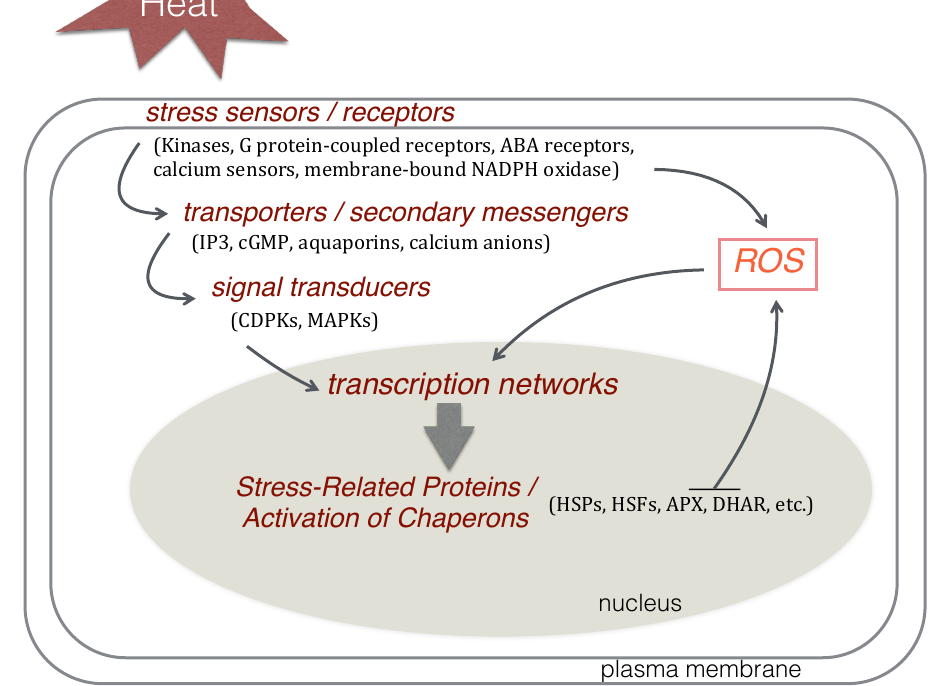
Figure 5. A simplified scheme for the heat-stress signal transduction pathway focusing on major regulatory components and stress-responsive genes identified so far in the grapevine. Protein stress sensormoleculesperceiveheat-stresssignalsandtransmitthemthroughsecondarymessengersinitiating transcription networks to provide stress tolerance. Abbreviations: IP3, inositol 1,4,5-trisphosphate; cGMP, 3 (cid:48) ,5 (cid:48) -cyclic guanosine monophosphate; CDPKs, calcium-dependent protein kinases; MAPKs, mitogen-activated protein kinases; HSPs, heat shock proteins; HSFs, heat stress transcription factors; APX, ascorbate peroxidase; DHAR, dehydroascorbate reductase; ROS, reactive oxygen